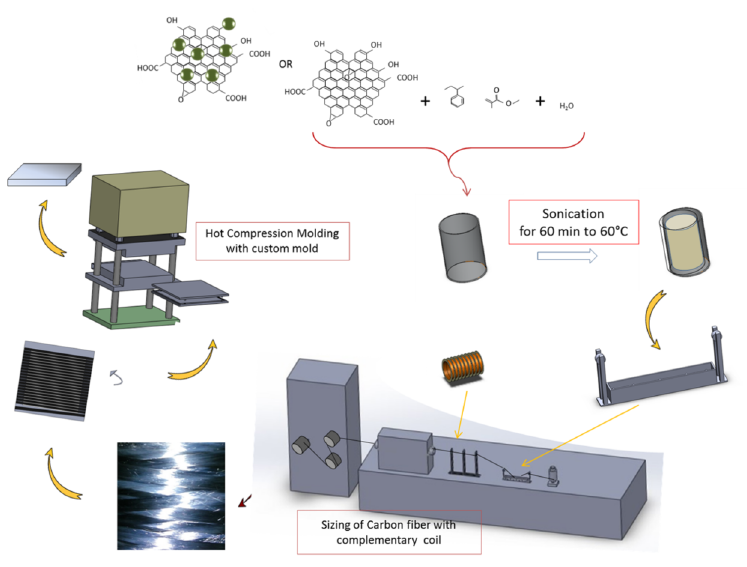
Figure 2. Schematic sizing process and making of the